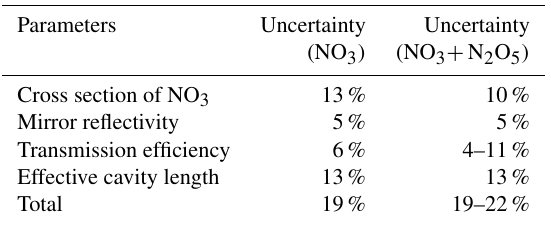
Table 2. Details of the uncertainties of the measurement of ambient NO 3 and NO 3 + N 2 O 5